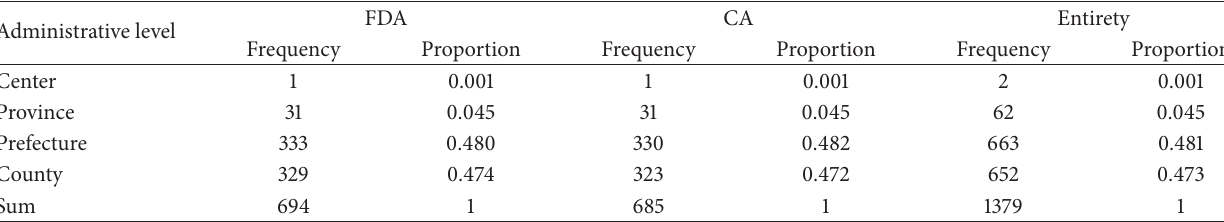
Table 4: Characteristics of different administrative